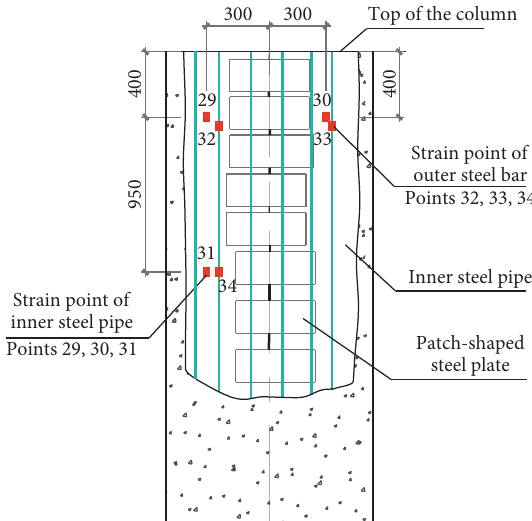
Figure 16: Strain point of the inner steel pipe and the outer steel rebars during the process of bearing capacity recovery.